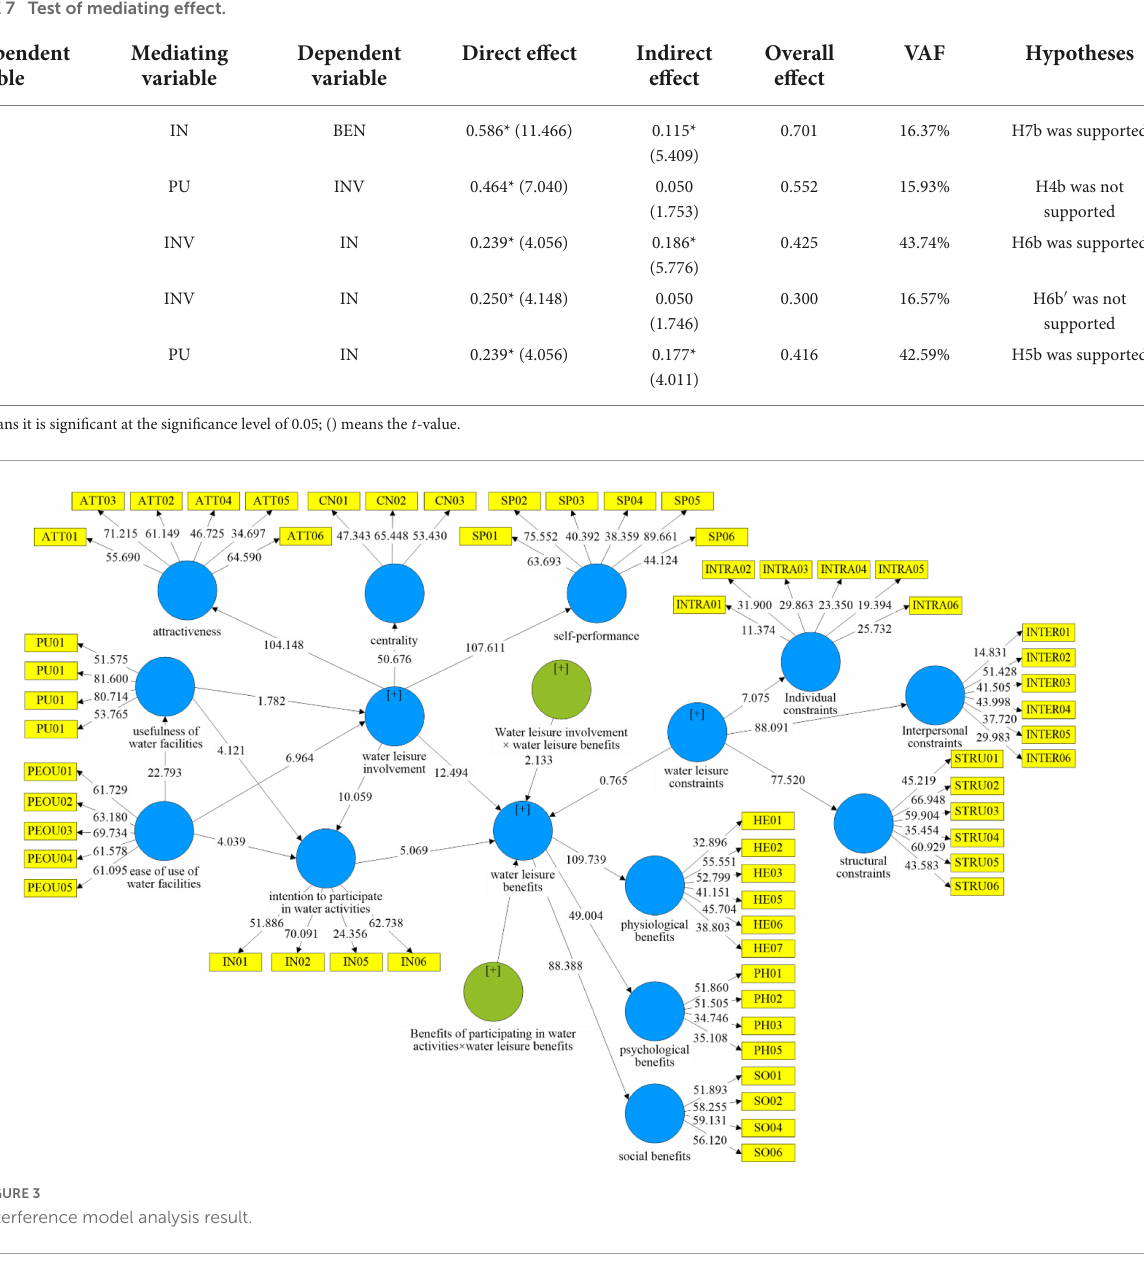
TABLE 7 Test of mediating effect.